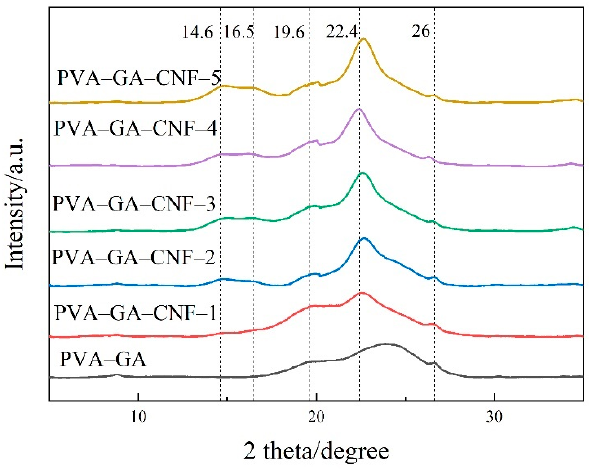
Figure 3. XRD patterns of PVA–GA aerogels and PVA–GA–CNF ‐ (1, 2, 3, 4, 5) aerogels .